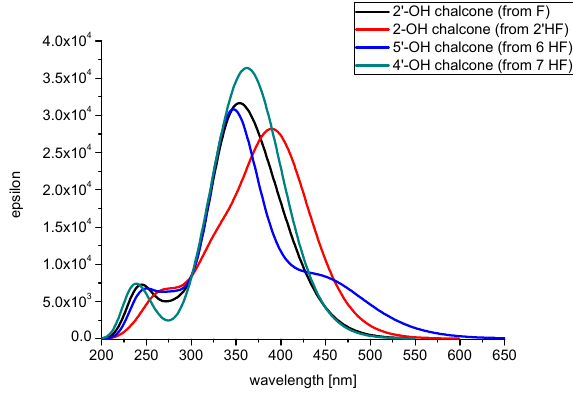
Figure 9. The simulated UV–Vis spectra of the chalcones: 2 OH chalcone (2’HF), 5’ OH chalcone (6HF), 4’ OH chalcone (7HF) and 2’ OH chalcone (F). (Gaussian 09 and GaussView 5.0.8; Origin(Pro) software).